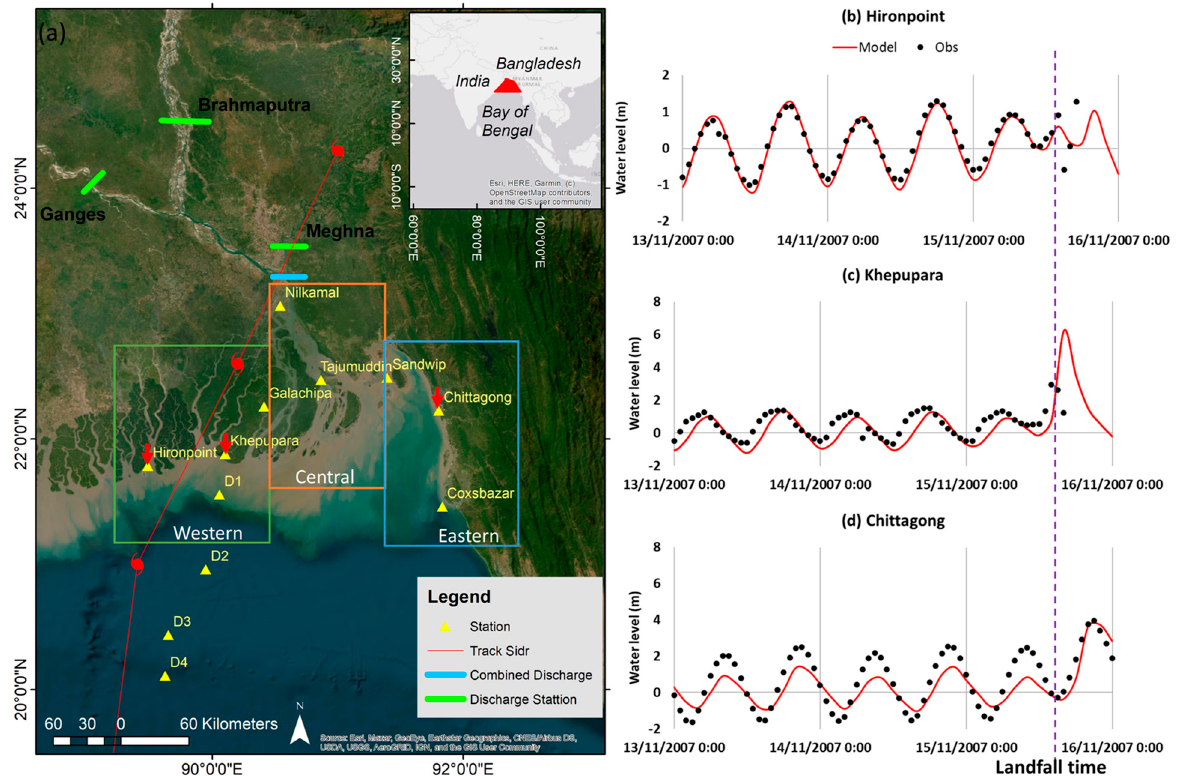
Figure 2. ( a ) The study area along with Cyclone Sidr and discharge boundary, ( b – d ) the model water level comparison with the observed water level at three stations for Cyclone Sidr. Different color boxes represent different regions of the GBMD. The purple dashed line denotes landfall time 1500 15 November 2007. Table 3. Statistical analysis of model water level compared with observations for cyclone Sidr. (Water Level)